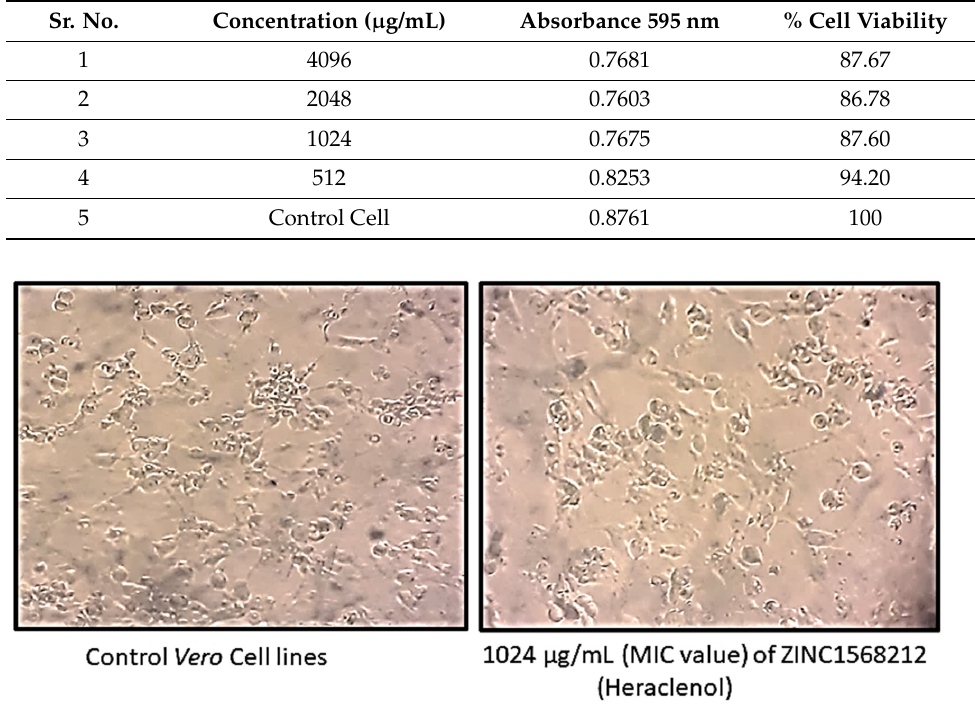
Figure 2. Effect of heraclenol on Vero cell lines. Heraclenol did not show any significant cytotoxicity as the morphology of the Vero cell line remained similar to the control cell line.